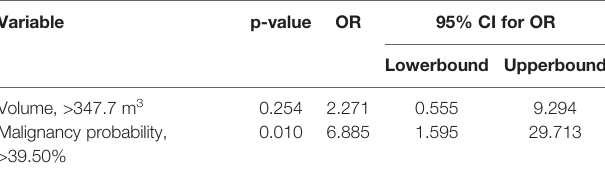
OR, odds ratio; CI, con fi dence